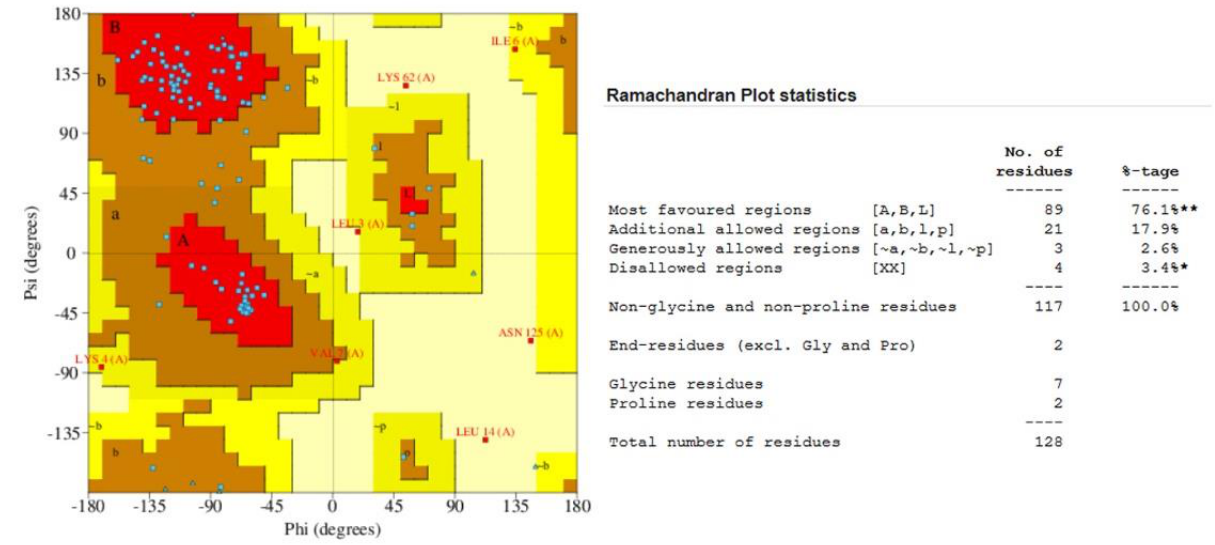
Figure 5. ProSA-web service quality assessment plots for refined ReFOLD model.